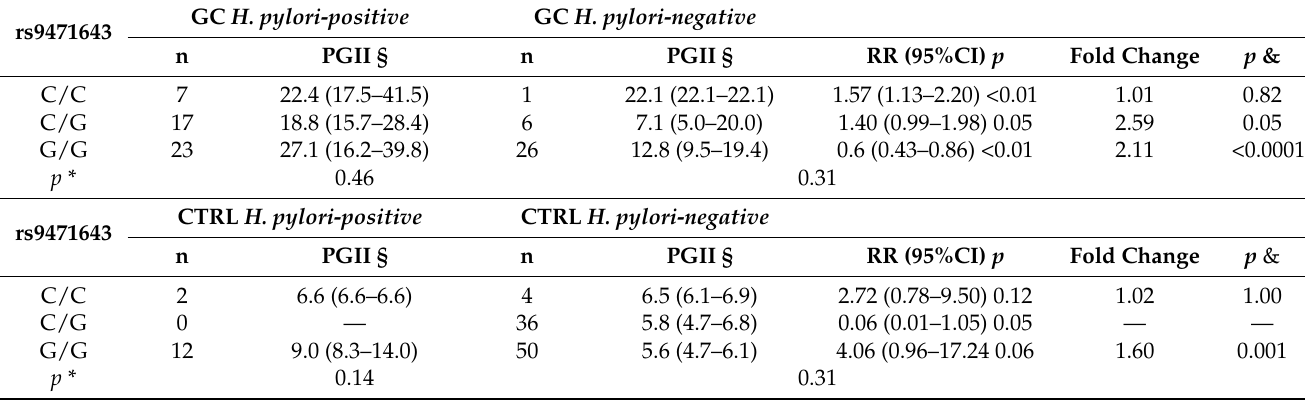
Table 7. Rs9471643 CC and CG genotypes are associated with the highest relative risk for H. pylori -positive gastric cancer, and CG genotype also with the highest increase in PGII serum level. By converse, the CG genotype is not found in H. pylori-positive controls.